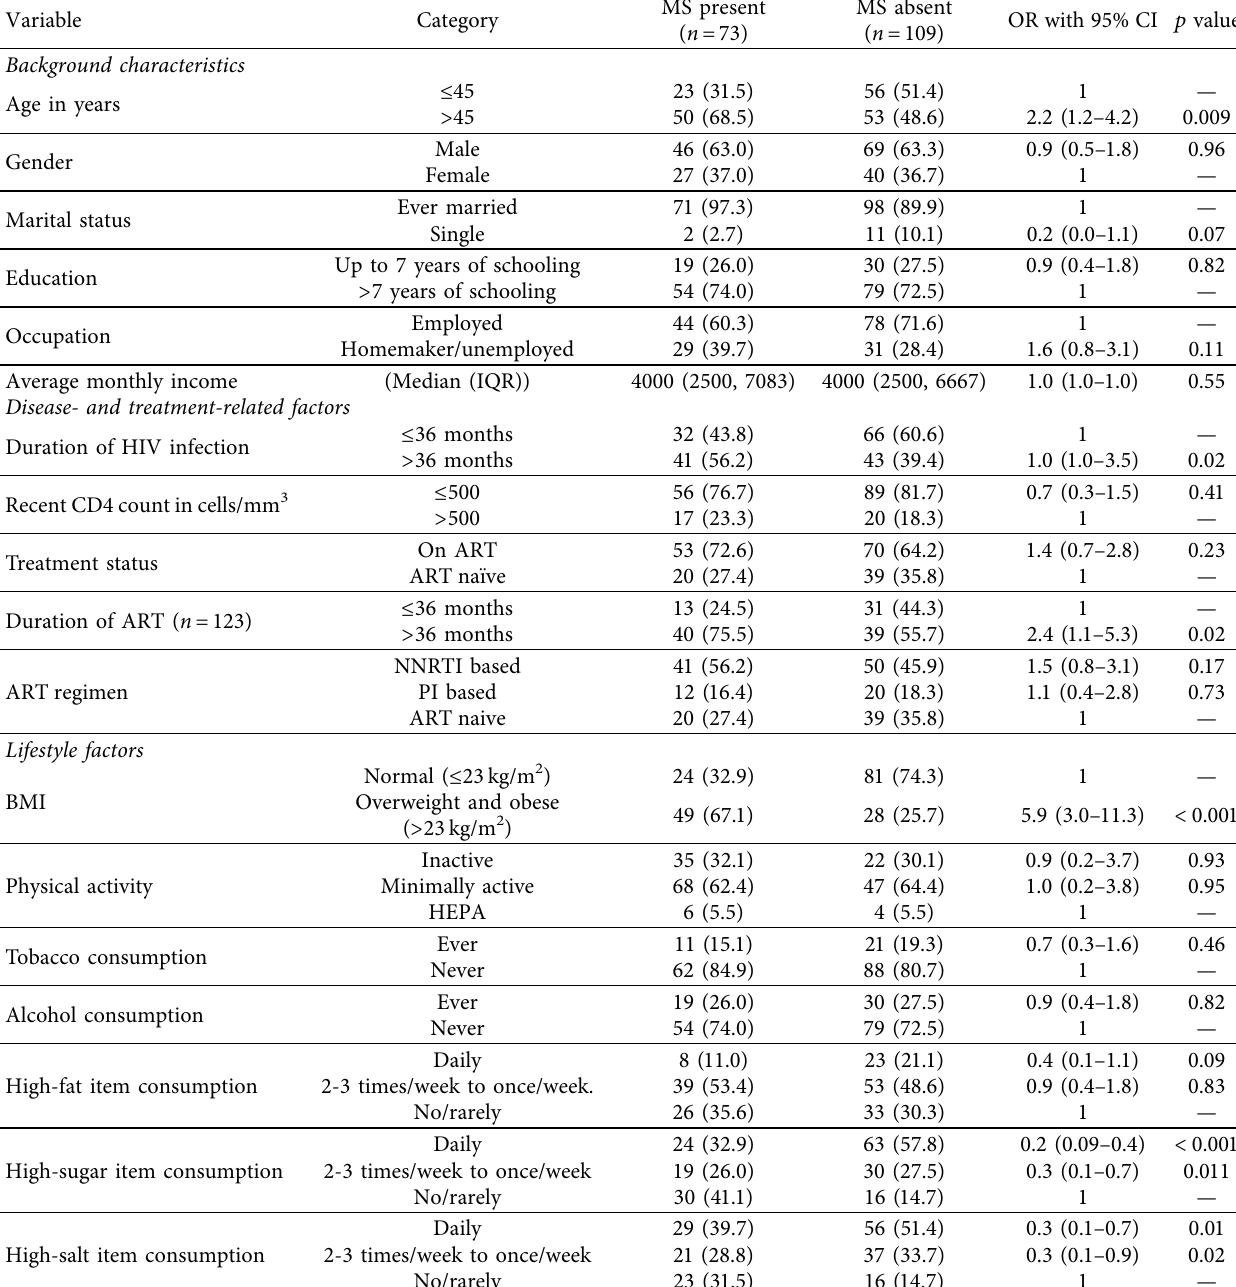
Table 3: Factors associated with MS on univariate analysis ( n �